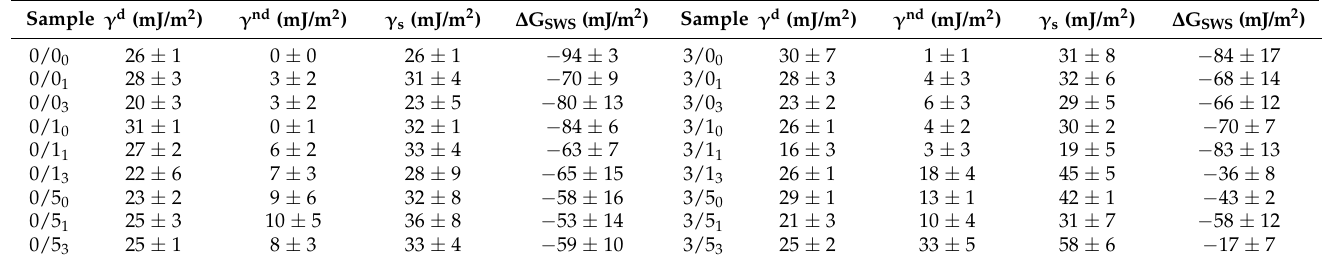
Table 1. Dispersive ( γ d ) and non-dispersive ( γ nd ) components of the surface tension, the total surface tension of the solid ( γ s ), calculated using the Owens–Wendt–Kaelble (OWK) approach and the free energy of interaction between two surfaces ( ∆ G SWS ). All data are given as mean and standard